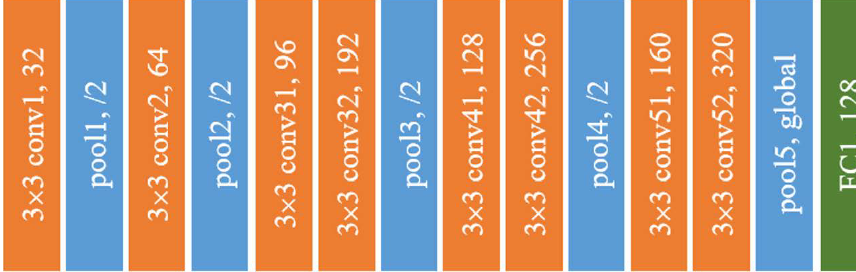
Figure 8: Network backbone for gait